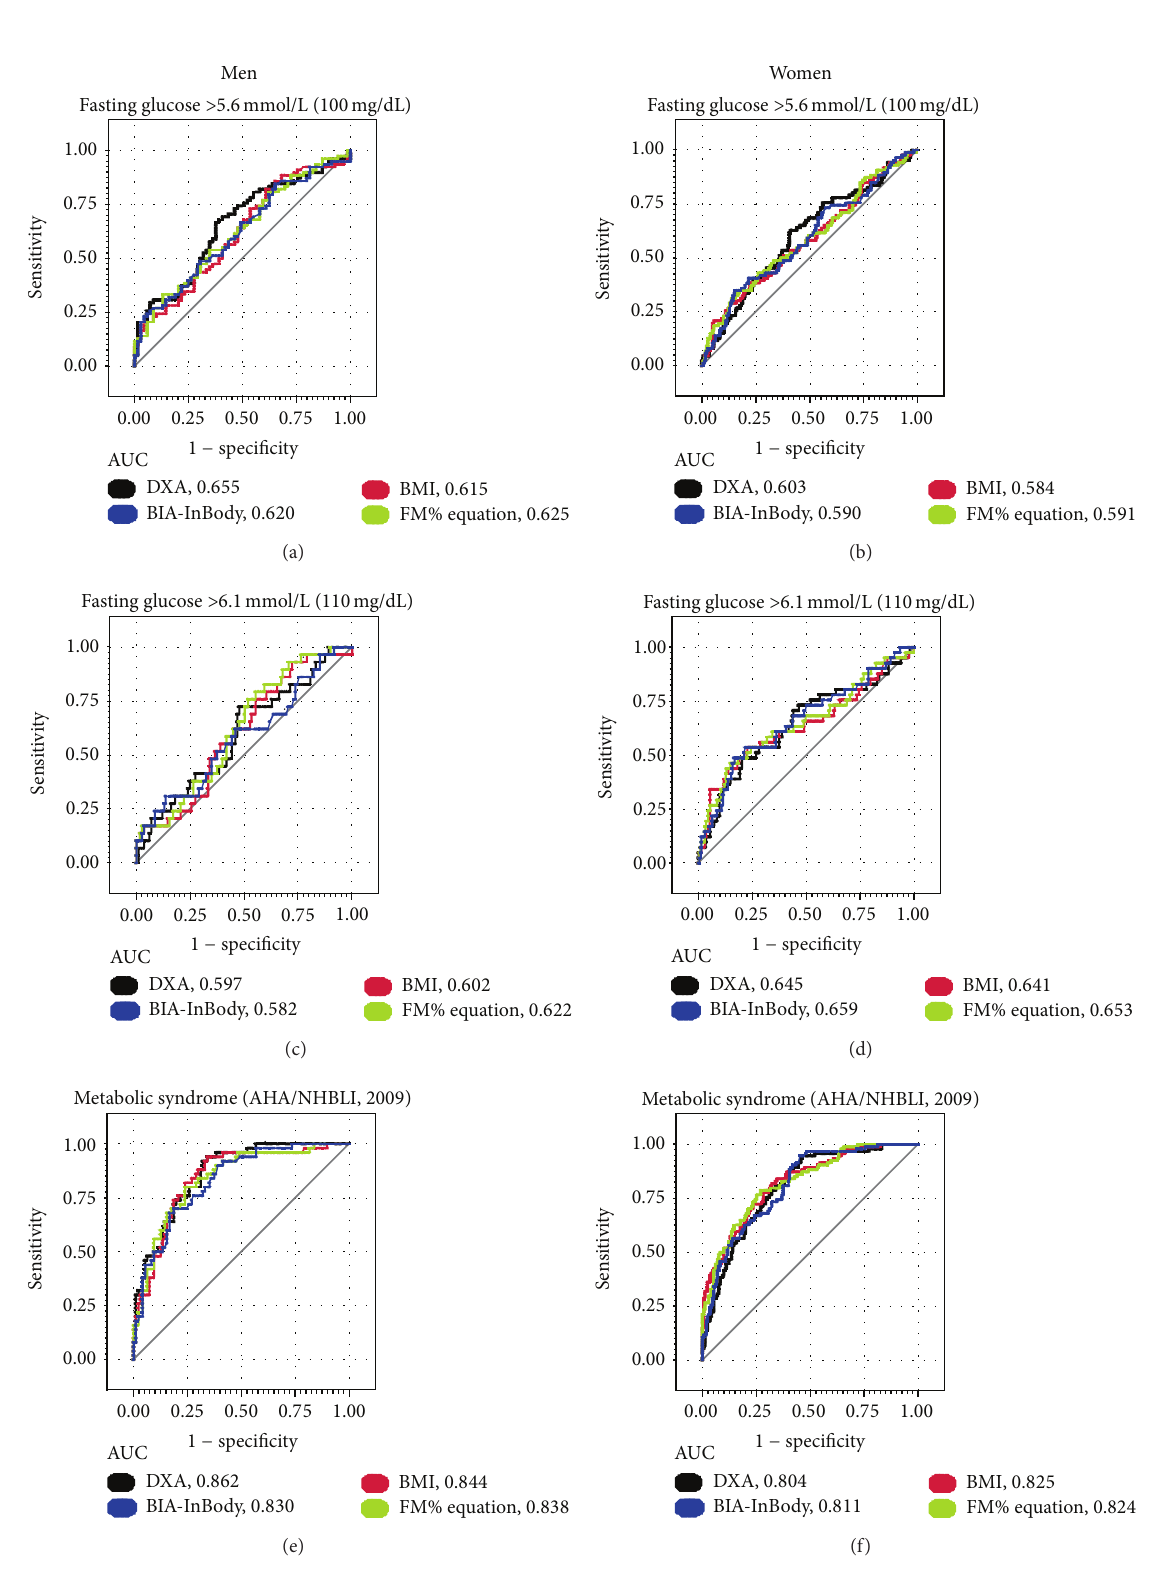
Figure 4: Receiver operating characteristic of DXA, BIA, BMI, and anthropometry-based estimate of fat mass percent (FM%-equation) as predictors of elevated fasting glucose and the metabolic syndrome. (a)–(f) There are no significant differences in direct comparisons of areas under curve (AUC) for the different